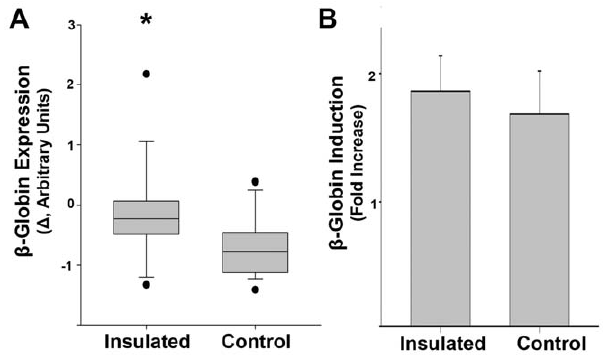
Figure 8. cHS4 insulator elements maintain long-term IHK– b - globin expression. ( A ) Change in b -globin expression from 4 to 14 weeks after transfection displayed as a box plot showing 10 th , 25 th , 50 th , 75 th , and 90 th percentiles within each population with outliers for the insulated pKT2/meIF- SB 100X-II b gI (n=18) and non-insulated pKT2/ meIF- SB 100X-I b g (n=20) clones. * indicates p , 0.001, paired t-test. ( B ) Fold increase in b -globin expression in response to hemin induction for insulated (n=17) and non-insulated (n=23) clones. Data shown as mean 6 SEM, difference between groups was not significant, p= 0.62.